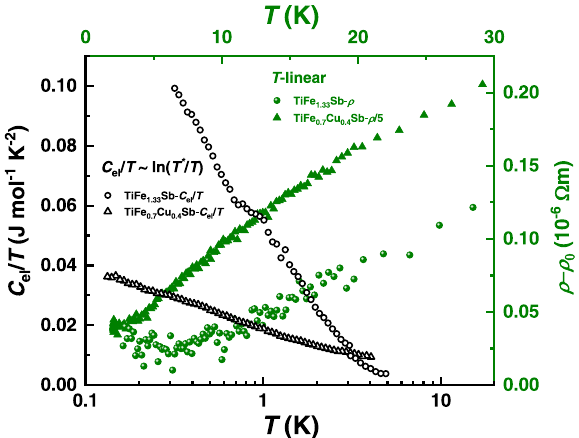
Fig. 3 Temperature-dependent electronic speci fi c heat capacities and resistivities of the TiFe 0.7 Cu 0.4 Sb and TiFe 1.33 Sb samples. Note that the electronic speci fi c heat coef fi cients are at least one order-of- magnitude higher than those of pure metals (for example, Cu 49 and CuNi 50 ) and even approach those of rare-earth-related heavy Fermi systems 51